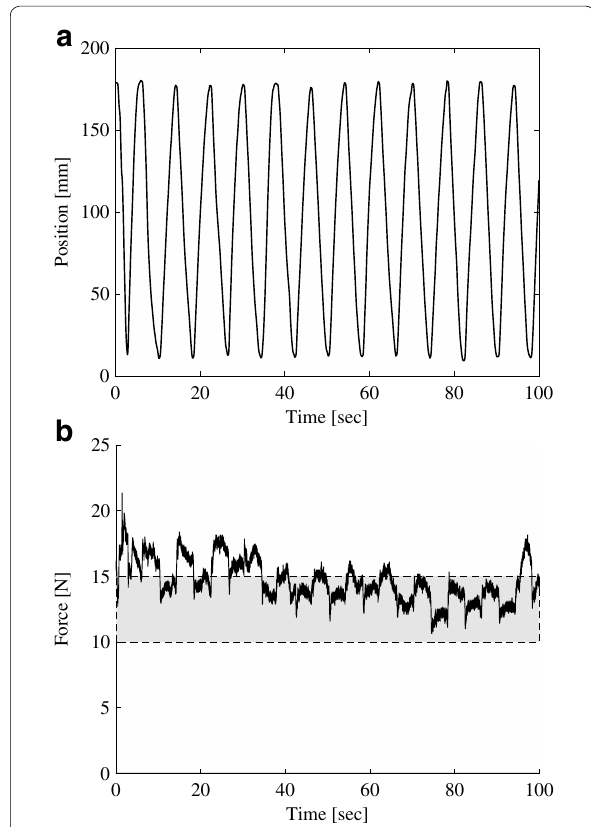
Fig. 13 In the experiment involving the conventional sensor, the graphs show a the position and b pressing force for each time